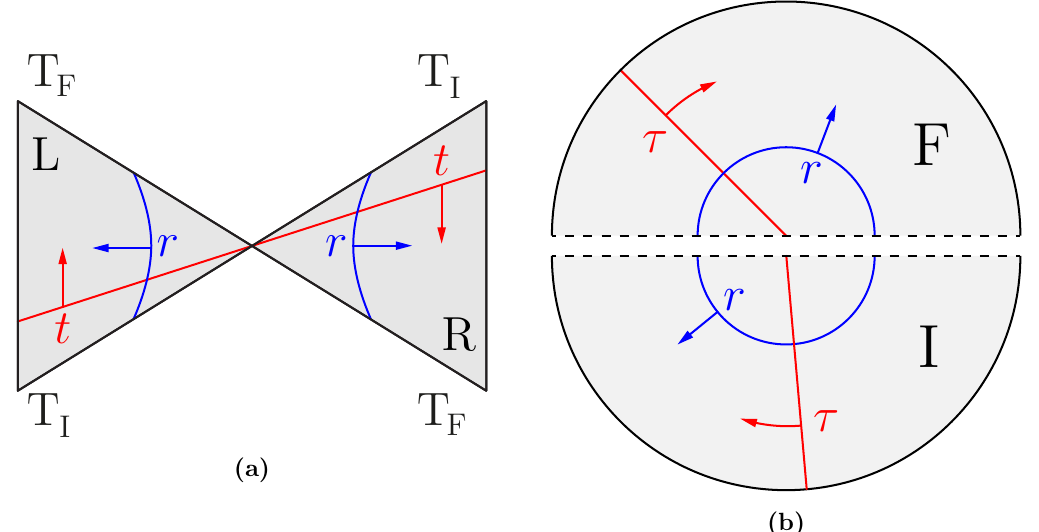
Figure 4 . (a) Static patches of the AdSBH with constant t; r surfaces depicted. Time runs upward in the left wedge (L) and downward in the right wedge (R). The angular variable ’ in (3.1) has been suppressed. (b) Euclidean AdSBH: time becomes an angular variable (cid:28) (cid:24) (cid:28) + 2 (cid:25) . The two pieces are identical and their temporal extension is (cid:12)=